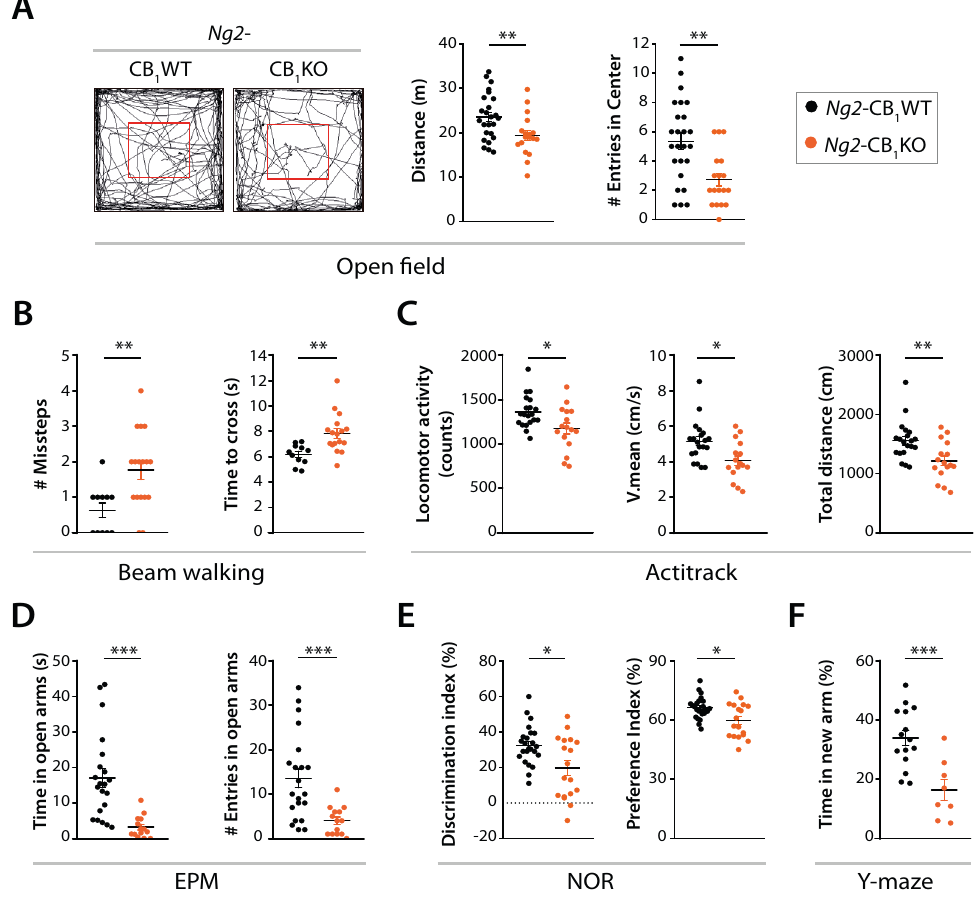
Fig. 3 Genetic inactivation of CB 1 receptor in OPCs causes motor and cognitive defects in young adult mice. Tamoxifen-driven recombination was induced in Ng2 -CB 1 KO, and control mice at postnatal day 6 (P6-P7) and a battery of behavioural tests was performed at P60. A Open fi eld test. Representative mouse trajectories, quanti fi cation of total distance travelled and the number of entries into the center of the arena. B Beam walking test. Quanti fi cation of the number of missteps and the time spent to cross the beam. C Actitrack test. Quanti fi cation of locomotor activity, mean velocity, and the total distance travelled. D Elevated plus-maze (EPM) test. Quanti fi cation of the time spent in open arms and of the number of entries into open arms. E Novel object recognition (NOR) test. Quanti fi cation of the discrimination index and the preference index. F Y-maze test. Quanti fi cation of the time spent in the new arm. Data are shown as mean ± SEM. n = 8 – 25 independent data points used per each experimental group. * p ≤ 0.05, ** p ≤ 0.01, *** p ≤ 0.001 vs Ng2 -CB 1 WT mice, by two-tailed unpaired Student ’ s t -test, two- tailed unpaired Student ’ s t-test with Welch ’ s correction or Man Whitney CB 1 receptors modulate OPC differentiation through the RhoA/ROCK signaling axis